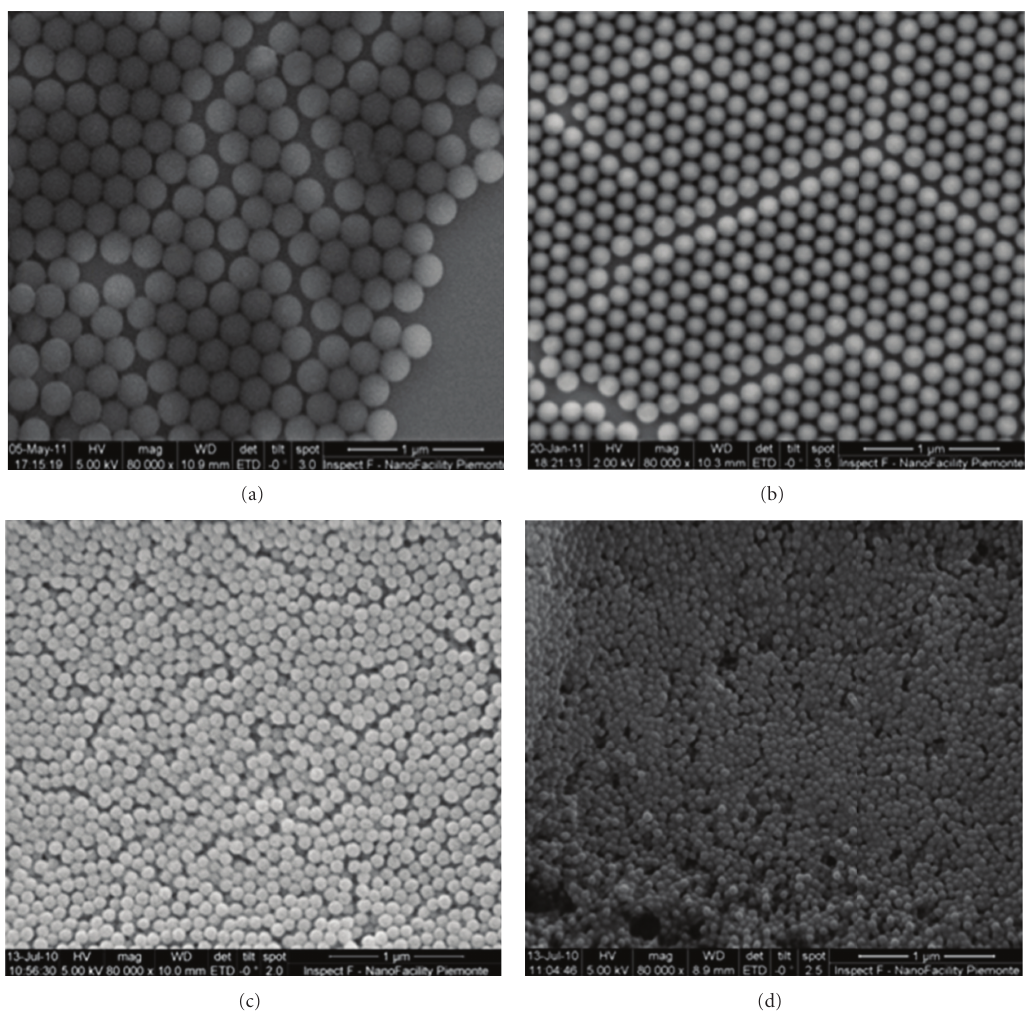
Figure 7: SEM micrographs of samples BPM1 (a), BPM2 (b), BPM4 (c), and BPM6